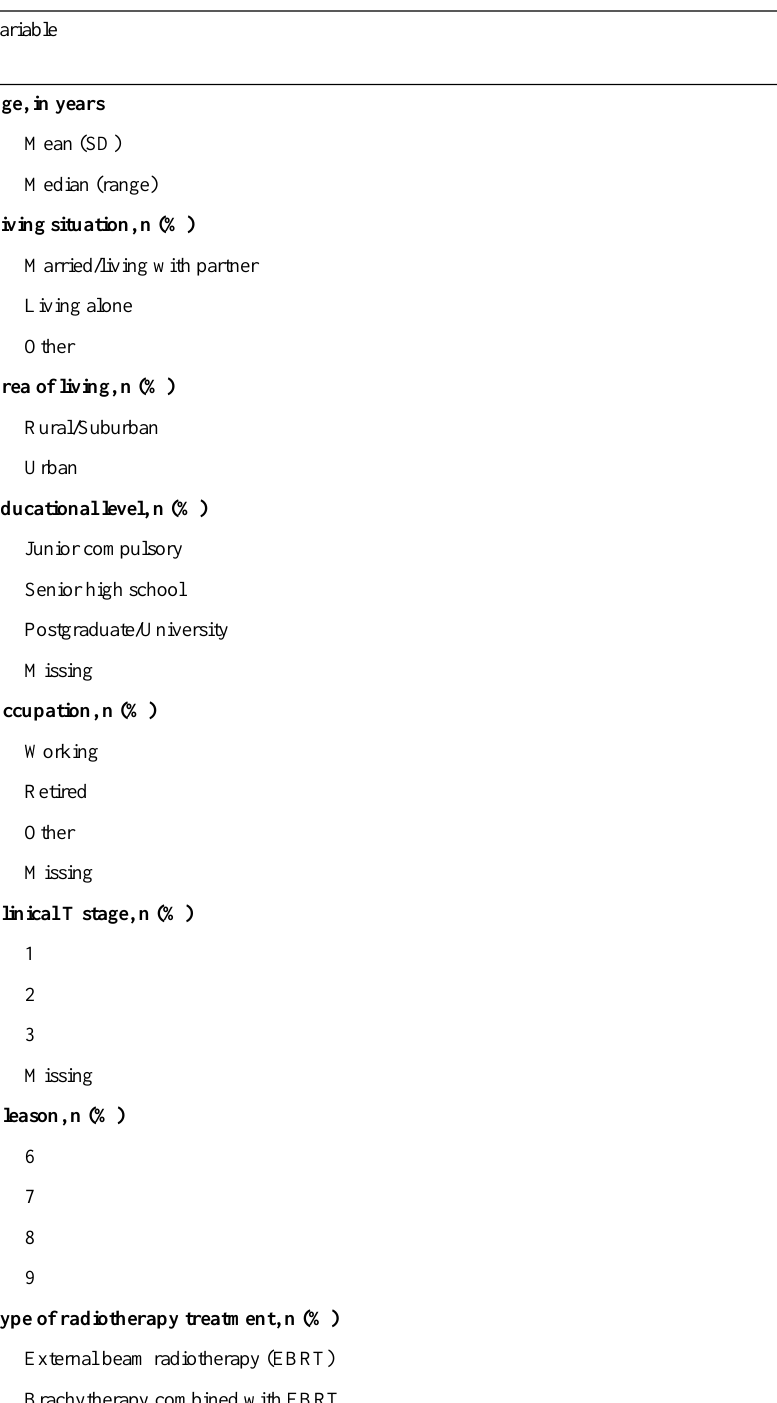
Table 1. Sociodemographic and clinical characteristics for patients with prostate cancer (N=28) included in the smartphone app and standard care